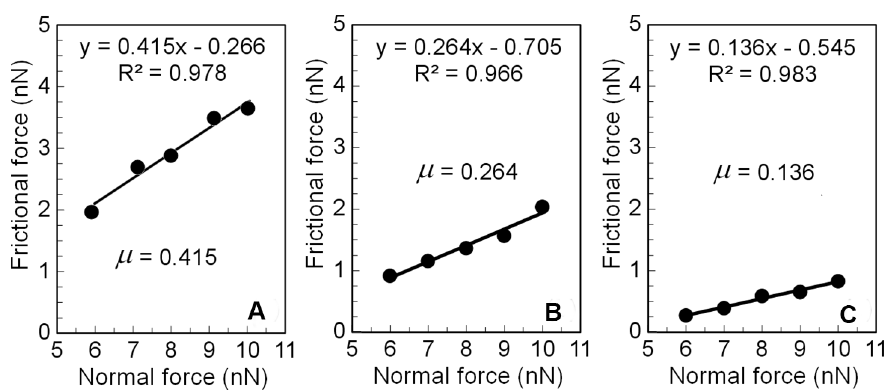
Figure 5. Representative plots of frictional versus normal forces for advanced OA cartilage measured in the lubricants of (A) PBS and, (B) HA 3.0 mg/ml, and (C) c –globulin 2.0 mg/ml. The linear slope yielding the AFM frictional coefficient measured for five values of the normal force in the range of 6–10 nN at an increment of 1 nN at each location.